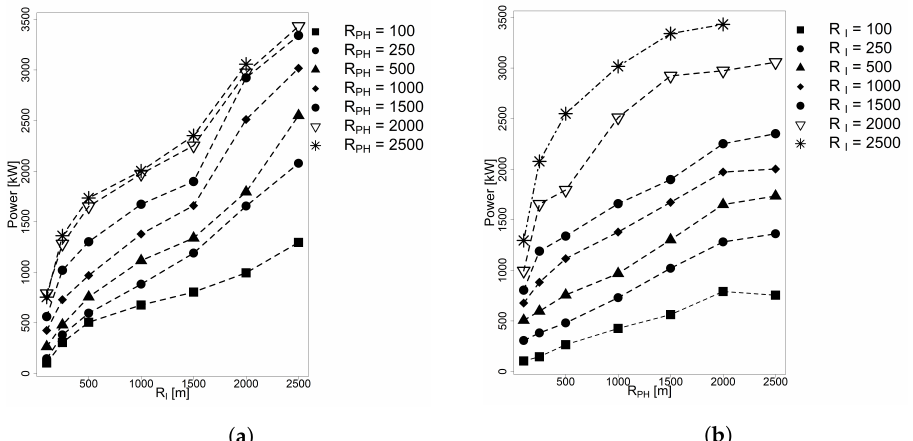
Figure 11. Power as function of R I and R PH for mean of 243 maximum values. ( a ) Fixed R PH value ( b ) Fixed R I value.